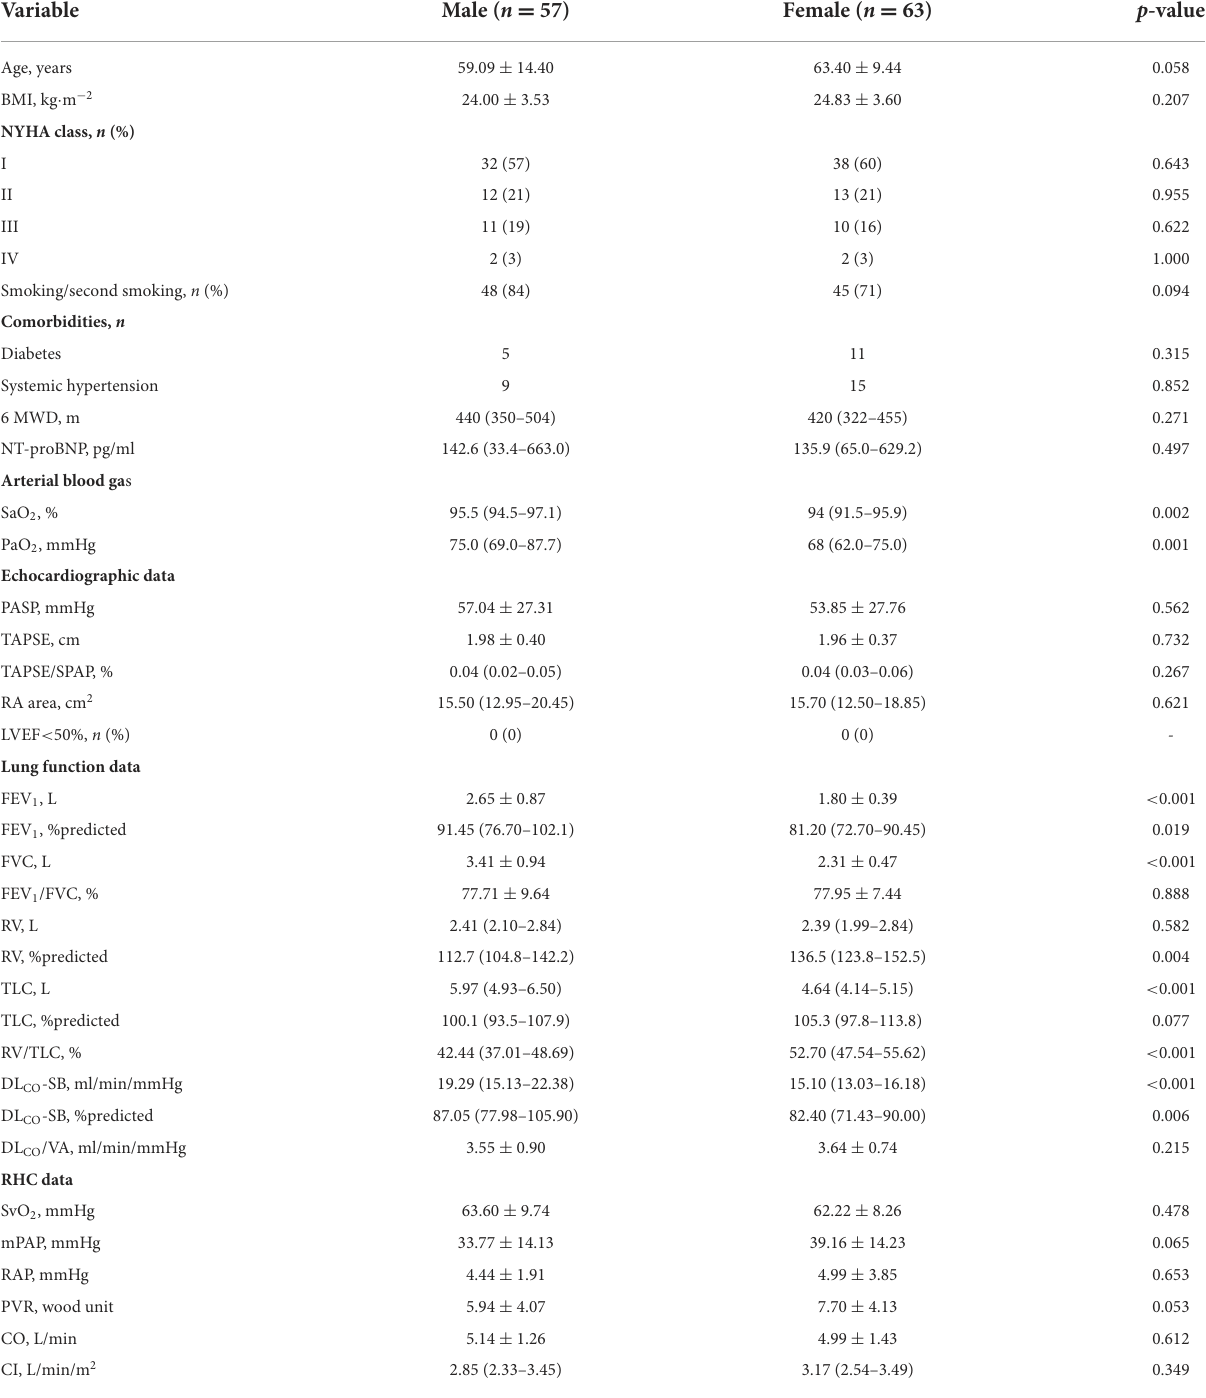
TABLE 1 Demographic and baseline clinical characteristics of all